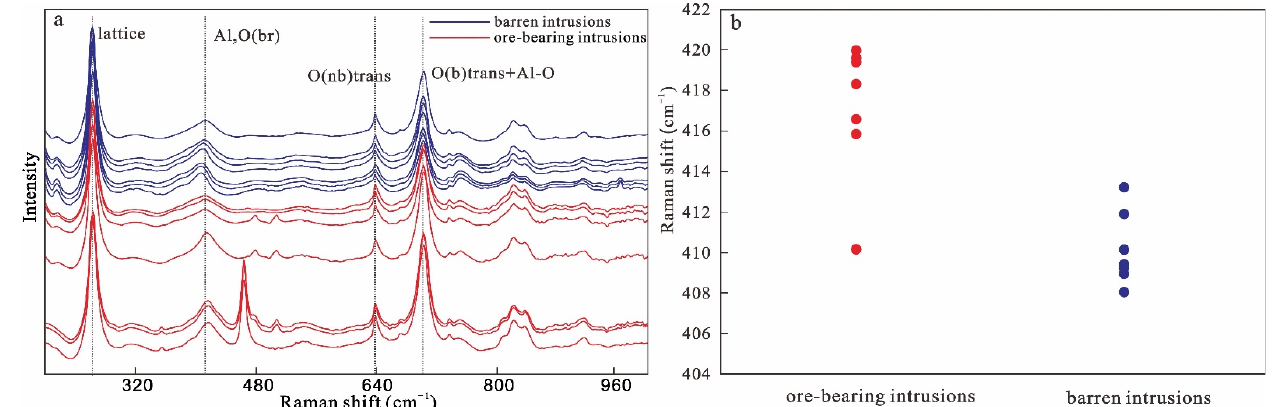
Figure 4. ( a ) Micro-Raman spectra of white mica from ore-bearing intrusions and barren intrusions; ( b ) The Raman shift of aluminium atom bridge-bonds (Al, O (br)) for white mica from ore-bearing intrusions and barren intrusions.